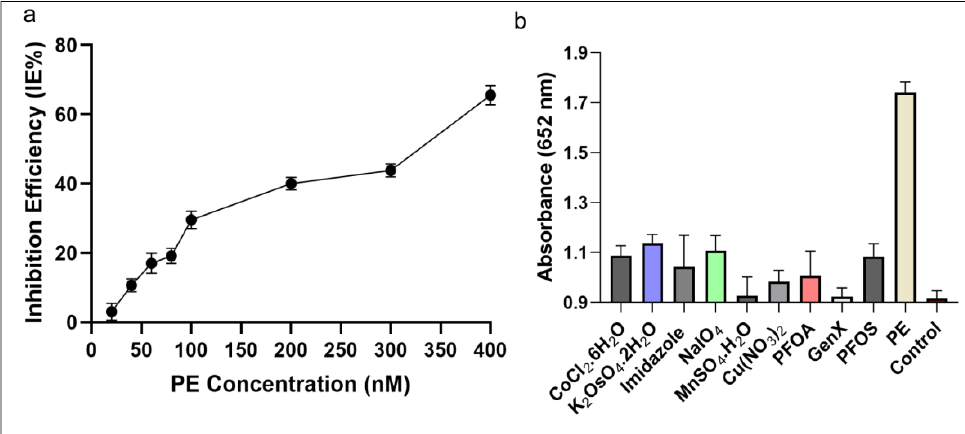
Figure 7. Inhibition efficiency and specificity of the assay ( a ) The IE% of PE on AChE activity demonstrates that with growing concentration of PE the inhibition of AChE increasing ( b ) The selectivity of the developed assay towards PE, carcinogenic compounds, and other toxins at a wavelength of 652 nm. The absorbance of PE was much higher compared to other compounds tested.